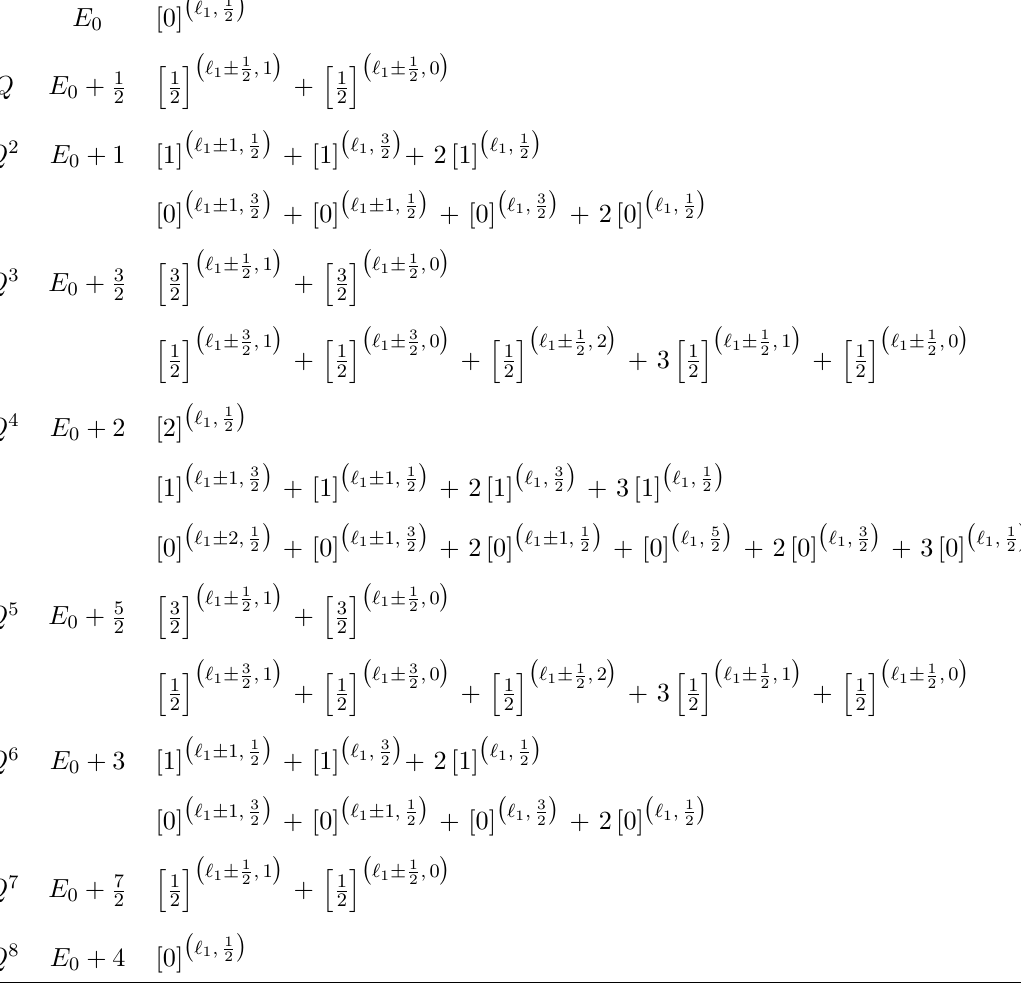
Table 10 . States in the long graviton supermultiplet LGRAV 4 the negative Dynkin label at the Q 4 level is